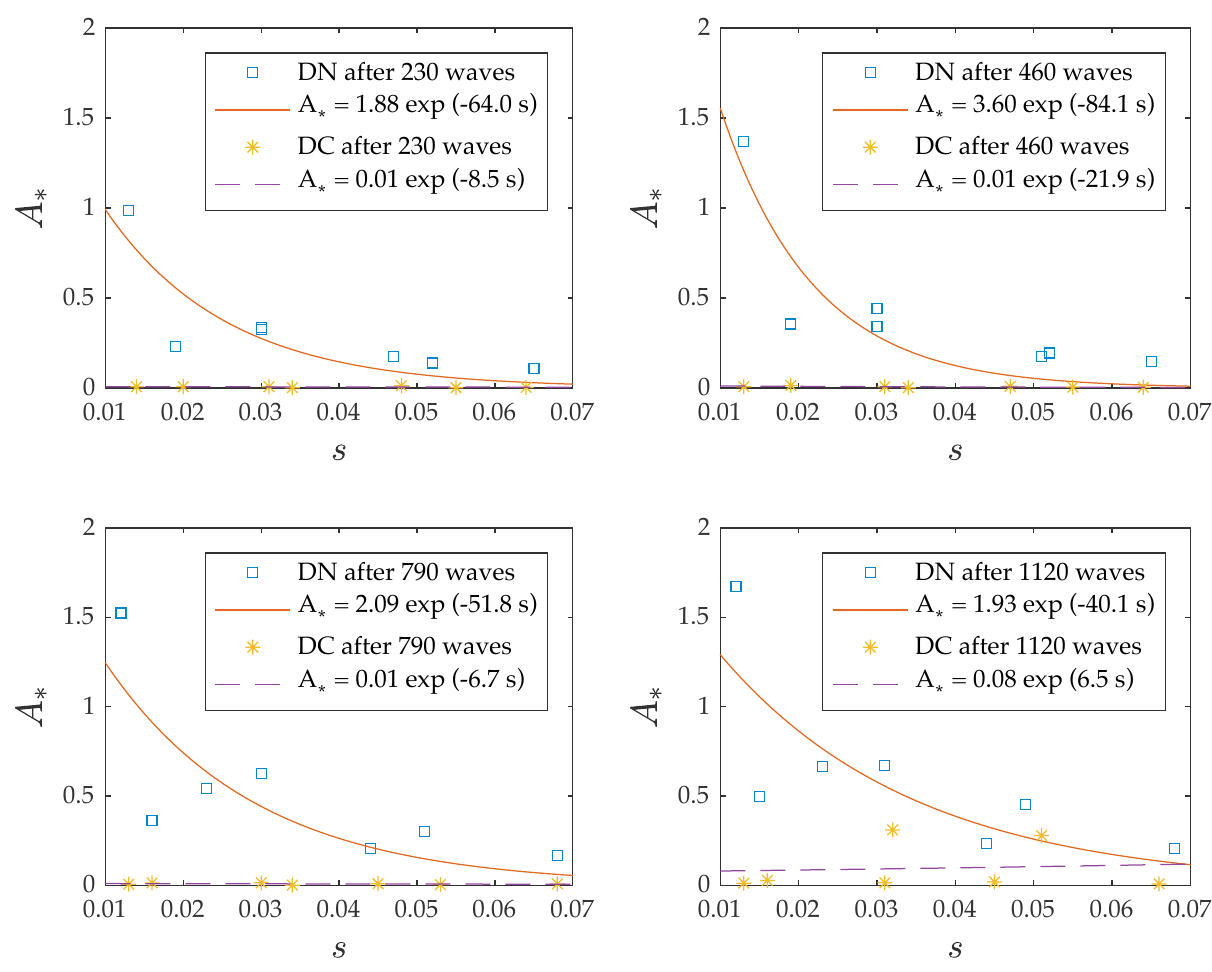
Figure 12. A ∗ as a function of s in the DN and DC tests for N = 230 ( upper left ), 460 ( upper right ), 790 ( lower left ), and 1120 ( lower right